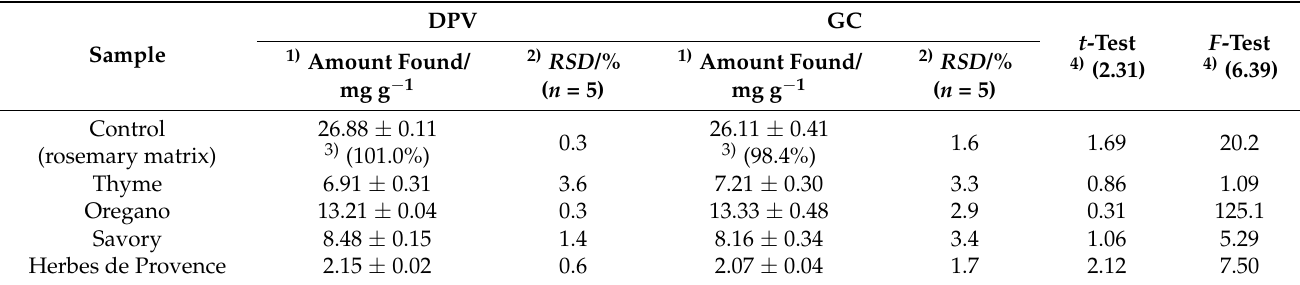
Table 2. Results of the isopropylmethylphenols determination in control and in spices samples by DPV compared with a reference gas chromatography (GC)